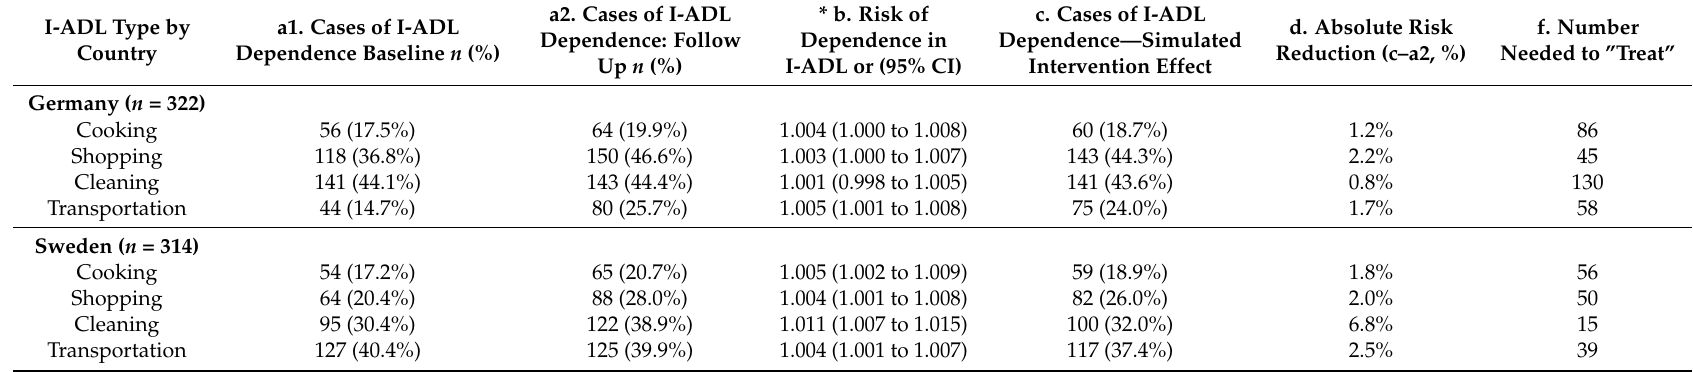
Table 2. Steps 2 and 3: simulated scenarios of absolute risk of becoming dependent in I-ADL, averted cases and number needed to